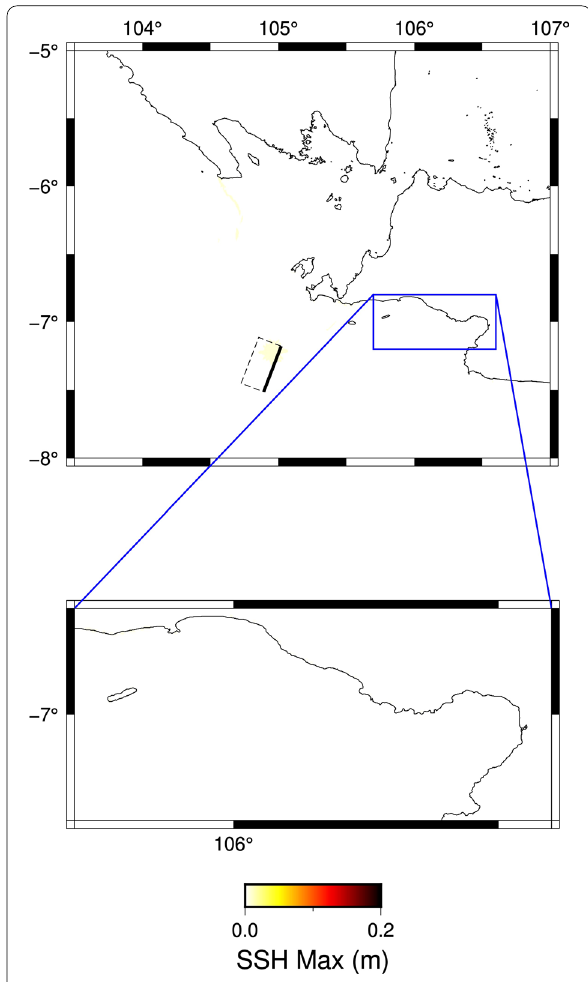
Fig. 7 The sea surface height maximum during simulation running for 2 h for a fault Model